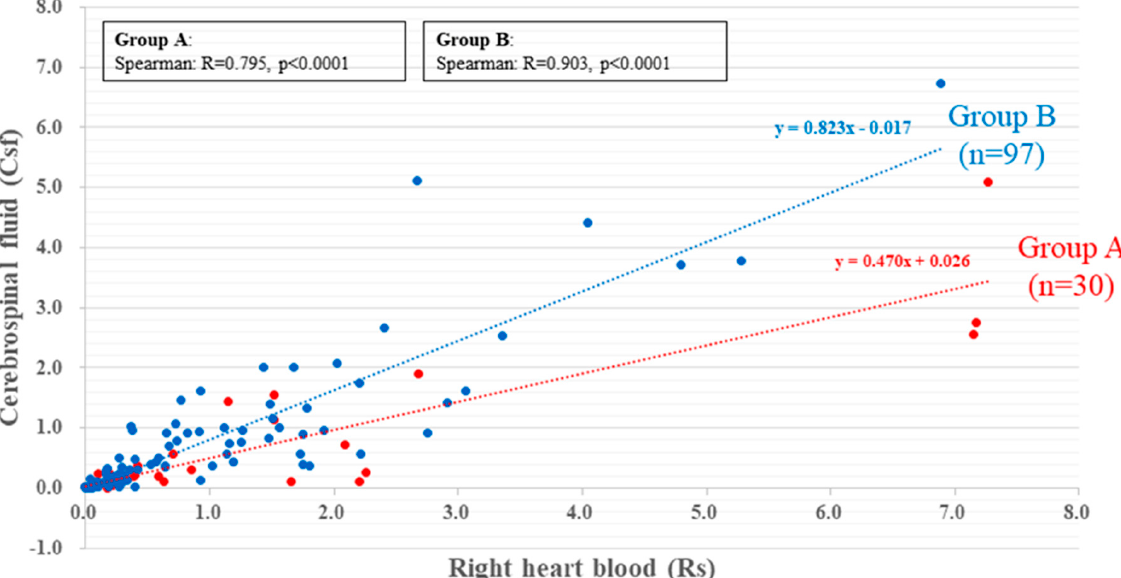
Figure 1. The correlation between the concentration of caffeine in Rs and that in CSF in Groups A (red) and B (blue). There is a correlation between the caffeine concentrations in Rs and in CSF in both groups (Group A: r = 0.795, p < 0.0001; Group B: r = 0.903, p < 0.0001). The concentration of caffeine is higher in Rs than in CSF in Group